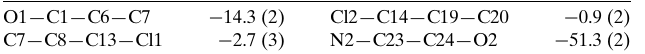
Table 2 Selected torsion angles ( (cid:3) ) for (II).